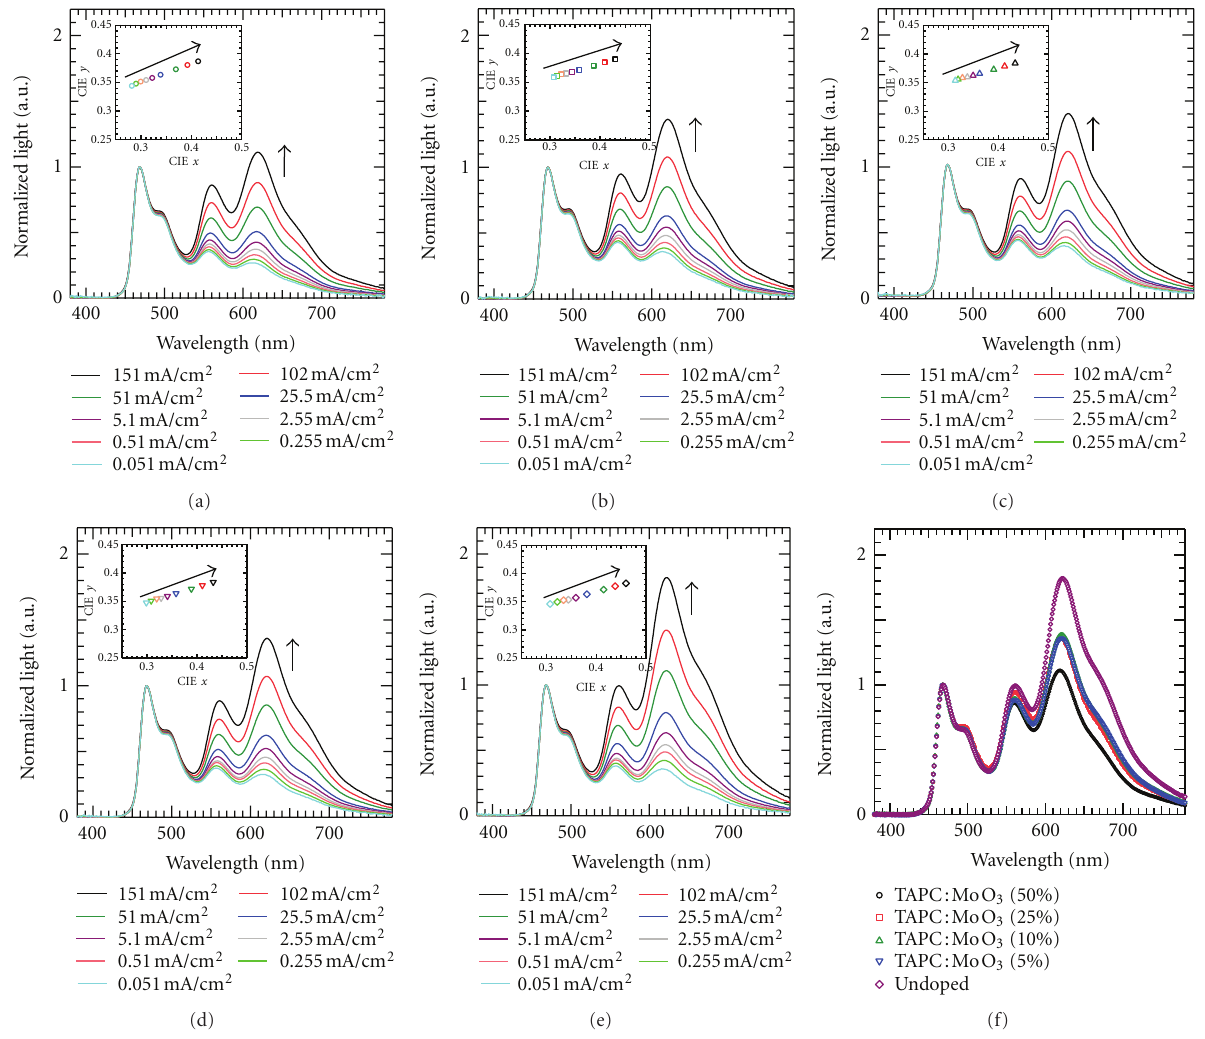
Figure 6: (a)–(e) Normalized EL spectra of WOLEDs with di ff erent current density at fixed doping concentrations and (f) with di ff erent MoO 3 doping concentrations at the same current density ( J = 153mA · cm − 2 ). Each inset shows the corresponding CIE color coordinates. The arrows indicate the spectral and CIE color coordinates variations with increasing current density from 0.051 to 153 mA · cm − 2 .